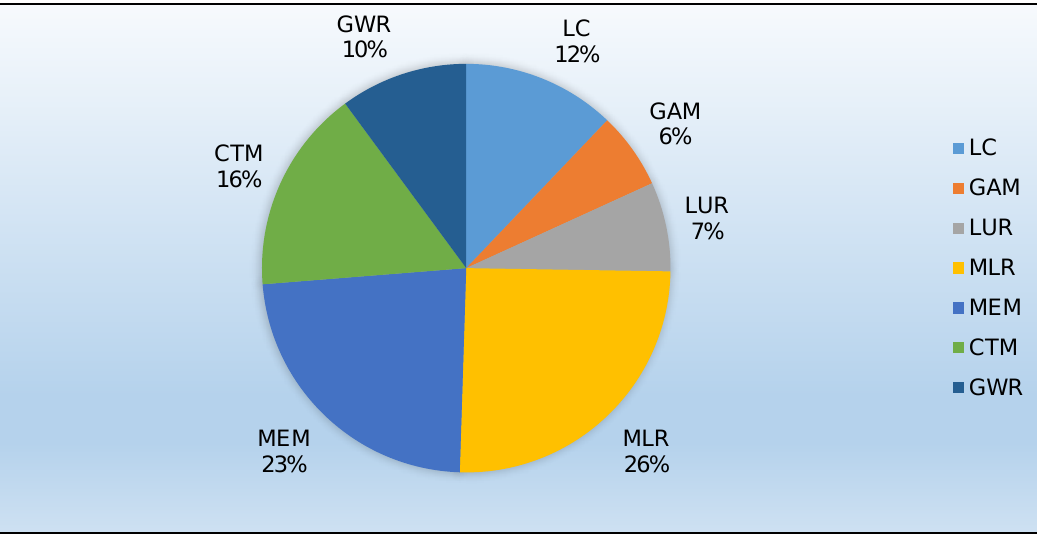
Figure 3. Constituent ratio of seven models.